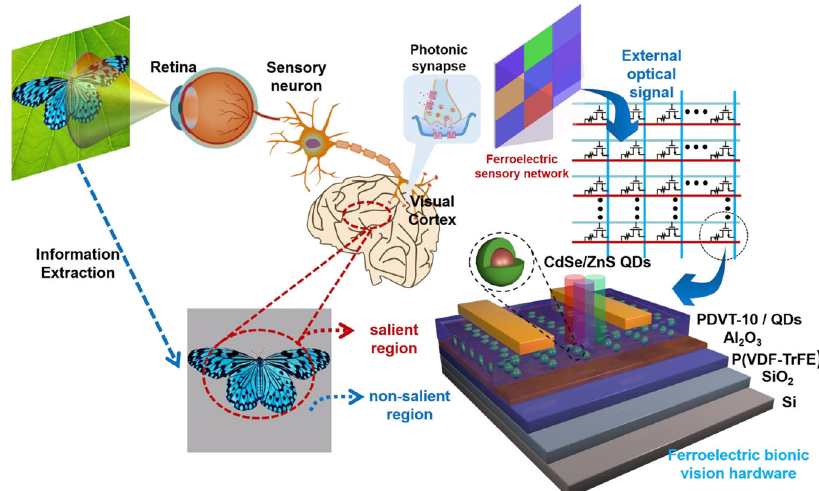
Fig. 1 | Schematic illustration of biological visual perception system and schematic con fi guration of individual arti fi cial ferroelectric bionic vision hardware. The biological vision system converts visual information into electrical signals and processes the signals in the cortex. Information extraction is a